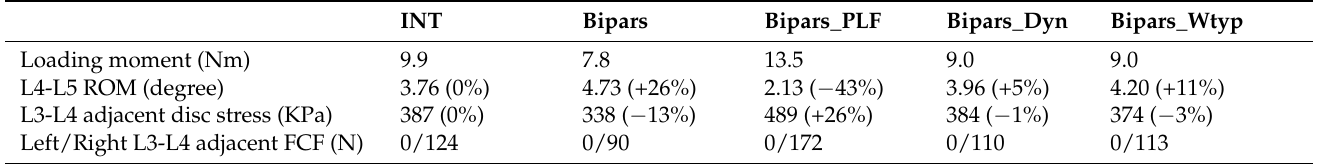
Table 5. ROMs, adjacent disc stress, and adjacent FCF in